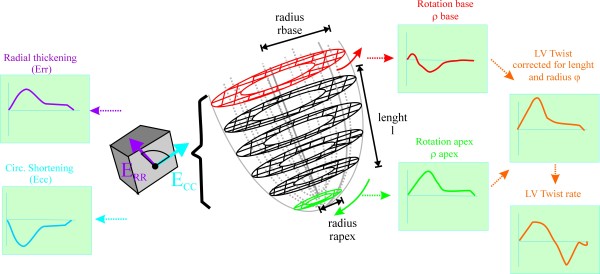
Illustration of the measurements obtained from tagged MR. Consecutive tagged short-axis planes were acquired from apex to base. On each short-axis plane, radial thickening (Err, purple) and circumferential shortening strain (Ecc, blue) were computed and the average of Err and Ecc for the entire left ventricle was recorded. Rotation of the most basal (red) and apical slice (green) slices were computed and left ventricular torsion (orange) was calculated as difference between apical and basal rotation divided by the length (l) between apex and base and multiplied by the mean radius of the base (rbase) and apex (rapex) to obtain LV twist (φ). The first derivate of LV twist over time was respectively systolic twist rate and diastolic untwist rate.